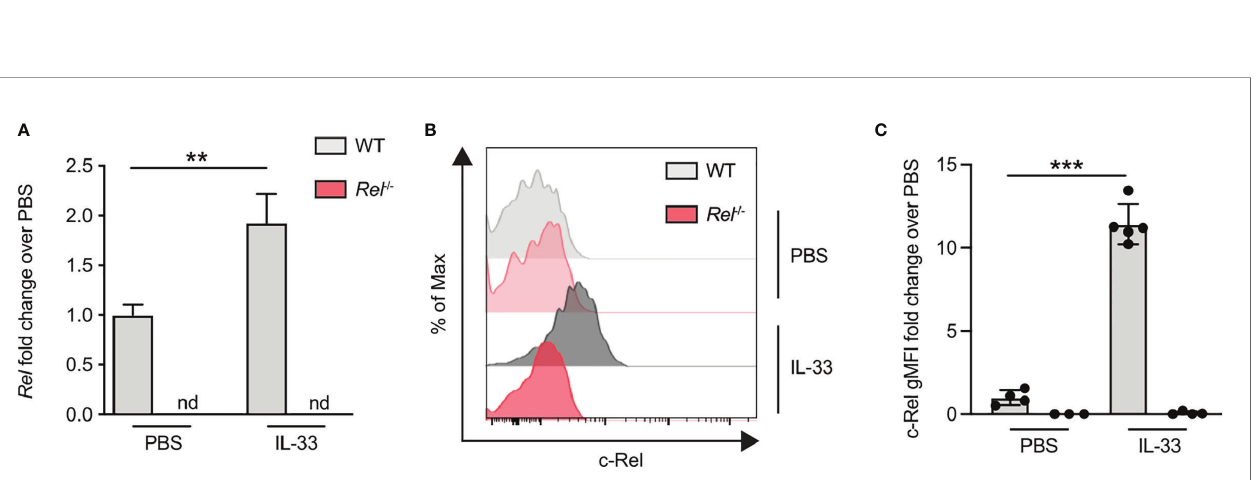
FIGURE 5 | c-Rel expression is induced in lung group 2 innate lymphoid cells (ILC2s) following intranasal challenge with IL-33. Wild-type (WT) (gray) and Rel − / − (red) mice were intranasally challenged for three consecutive days (days 0, 1, and 2) with either phosphate-buffered saline (PBS) or IL-33 (500 ng/mouse), and lungs were analyzed 24 h after the last administration. (A) Lung c-Rel transcript levels in WT and Rel − / − mice following intranasal challenge were determined by qRT-PCR, and (B, C) intracellular expression of c-Rel protein in lung ILC2s was analyzed by fl ow cytometry. (B) Representative histogram plots of intracellular c-Rel staining in pulmonary WT and Rel − / − ILC2s following intranasal challenge with PBS or IL-33 quanti fi ed as (C) gMFI fold change over the PBS-treated control group. Data points are representative of at least two independent experiments with n = 3 – 5 mice per treatment group. Data are shown as mean ± SD with **p < 0.01, and ***p < 0.001 as determined by one-way ANOVA followed by Tukey ’ s multiple comparisons test or by two-tailed t-test (unpaired). gMFI, geometric mean fl uorescence intensity; nd, not